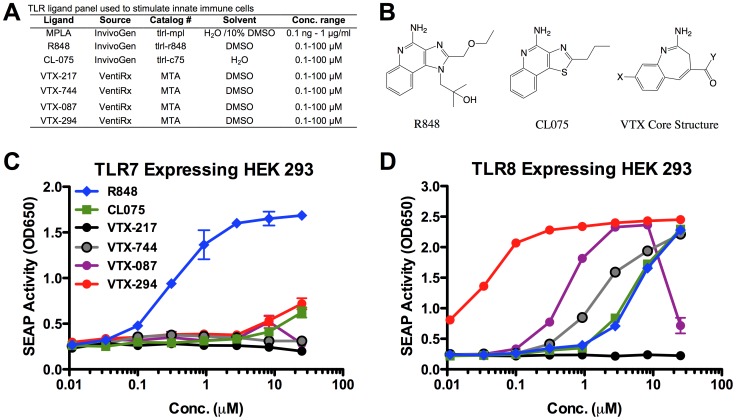
VTX-294 activates the NF-κB pathway via TLR8.(A) Seven TLR agonists were compared. (B) Representative structures of the TLR7/8 agonists used in this study. HEK-293 cells transfected with (C) human TLR7 and (D) TLR8 and an NF-κB-driven reporter SEAP gene were stimulated for 18–24 h with TLR agonists. The y-axis shows the level of SEAP activity in the Quanti-blue™ assay optical density (OD). The x-axis shows the concentration of each compound in µM. Each data point represents the mean ± SD of OD at 650 nm of triplicate culture wells. VTX-217 (black) is a structurally matched negative control for VTX-744 (gray), VTX-087 (purple) and VTX-294 (red). The IMQ benchmarks R848 and CL075 are denoted in blue and green, respectively.